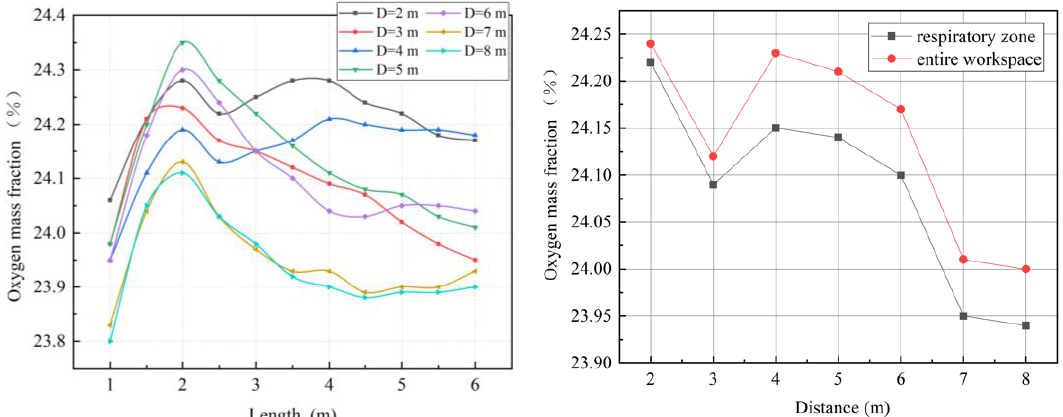
Figure 14. Characteristic diagrams of oxygen mass fraction distributions in the main working area. ( a ) Oxygen mass fractions along the roadway; ( b ) oxygen mass fractions in the respiratory zone and in the entire workspace.